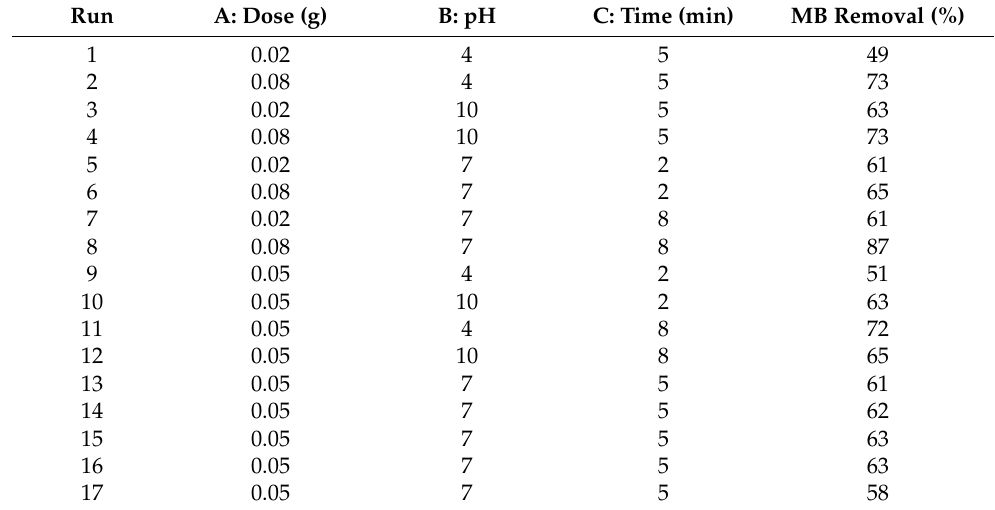
Table 3. Three-variable BBD matrix and experimental data for MB dye